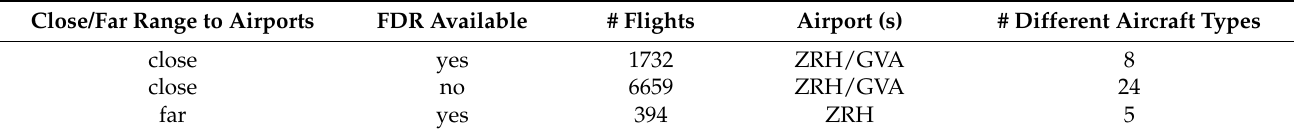
Table 3. Number of simulated flights and aircraft types.